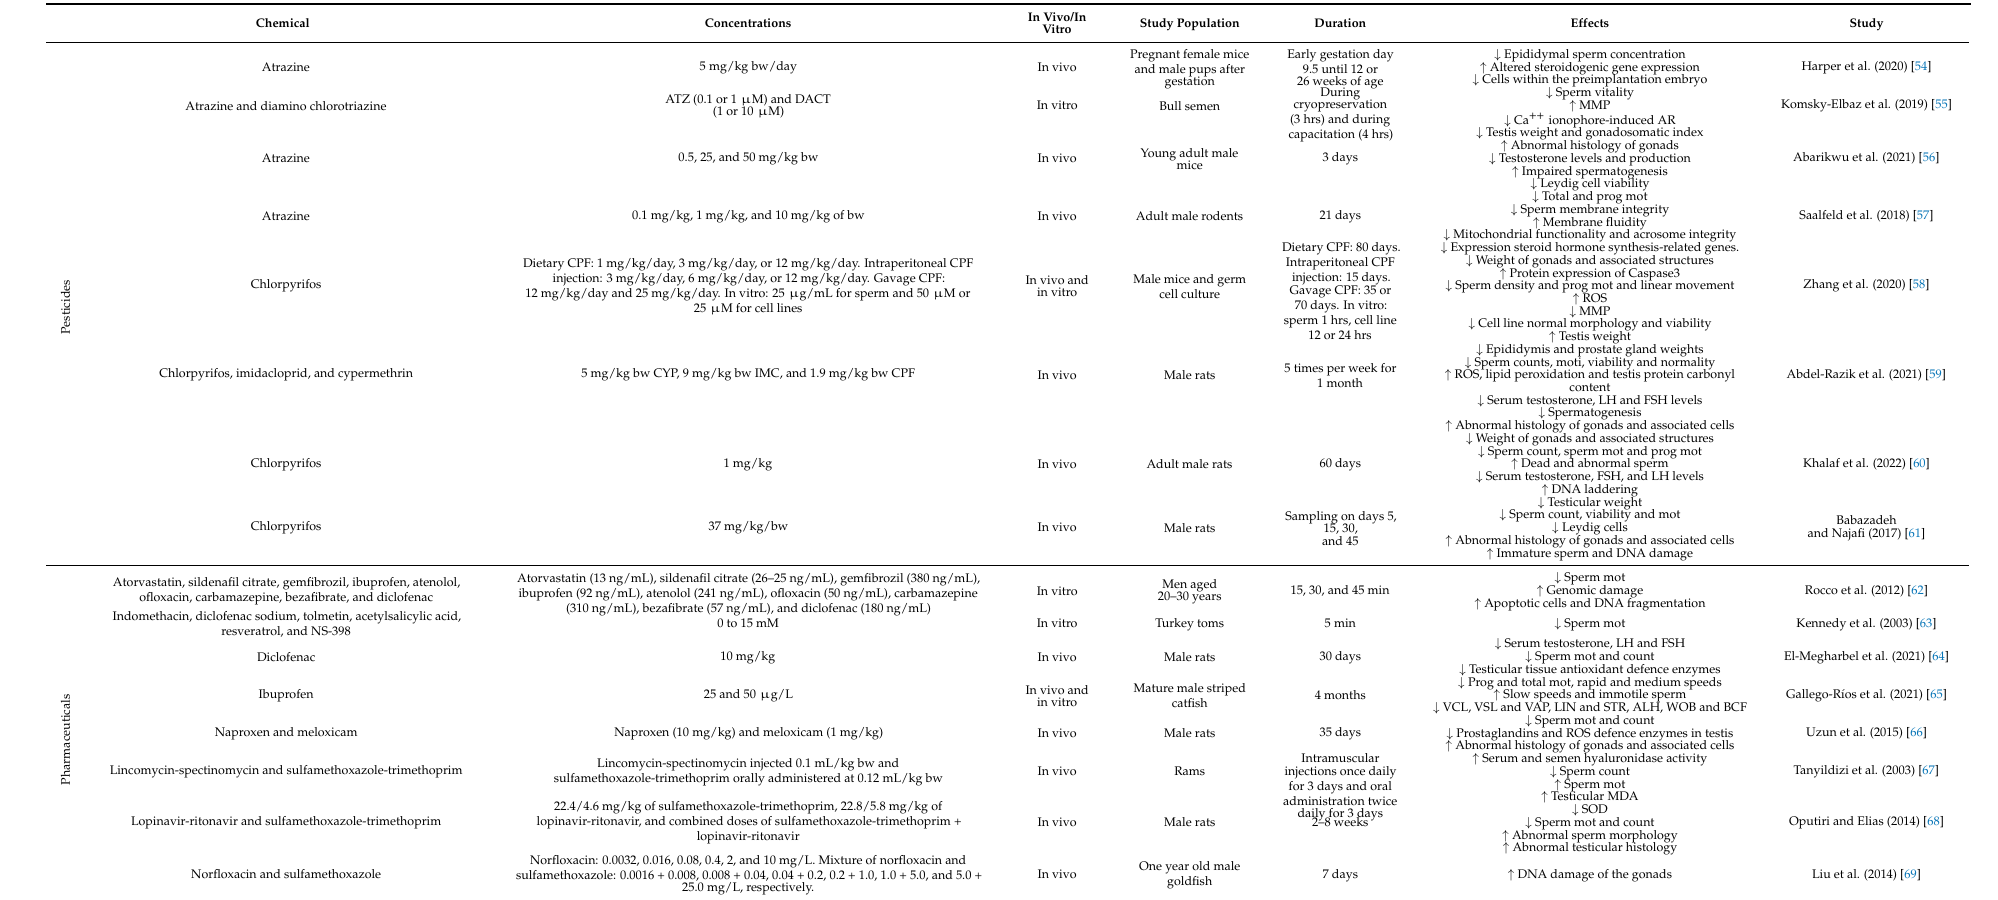
↑ DNAdamageofthegonads Liuetal. (2014)[69] Abbreviations: ↓ , decrease or negatively affected; ↑ increased or positively affected; ALH, amplitude of lateral head displacement; AR, acrosome reaction; AZT, atrazine; BFC, beat cross frequency; bw, body weight; COX, cyclooxygenase inhibitors; CPF, chlorpyrifos; CYP, cypermethrin; DACT, diamino chlorotriazine; DMSO, dimethyl sulfoxide; DNA, deoxyribonucleic acid; FSH, follicle stimulating hormone; GEH, germinal epithelium height; GPx, glutathione peroxidase; GSH, glutathione; hrs, hours; IMC, imidacloprid; LH, luteinizing hormone; LIN, linearity; min, minutes; MDA, malondialdehyde; MMP, mitochondrial membrane potential; Mot, motility; PGE, prostaglandin; Prog, progressive motility; RI, repopulation index; ROS, reactive oxygen species; SOD, superoxide dismutase; STD, seminiferous tubules diameter; STR, straightness; TDI, tubular differentiation index; VAP, average path velocity; VCL, curvilinear velocity; VSL, straight-line velocity; WOB,